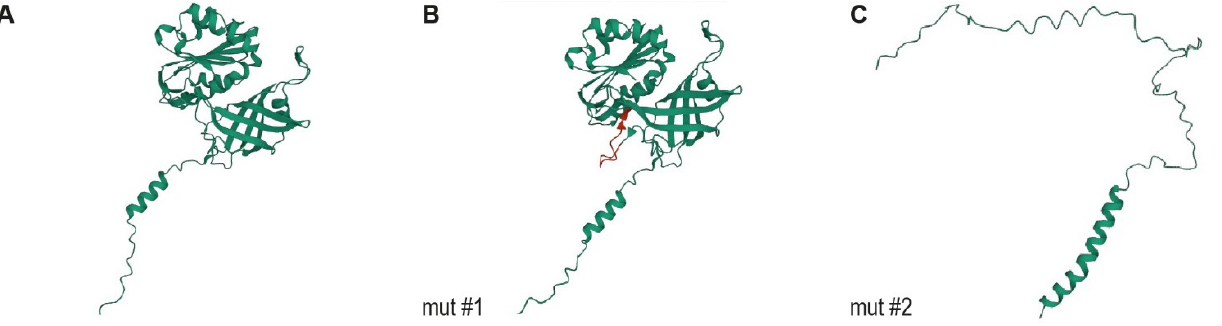
Figure 4. Protein modeling of CYB5R3. ( A ) Protein model of the wildtype feline CYB5R3 protein. ( B ) Protein model of the predicted translation product of transcript mut